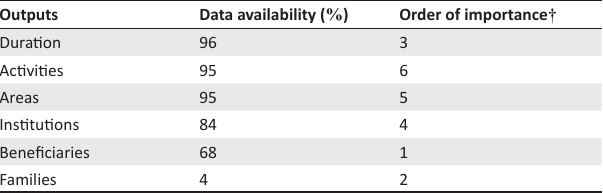
TABLE 5: Instrument efficiency: General model. Panel